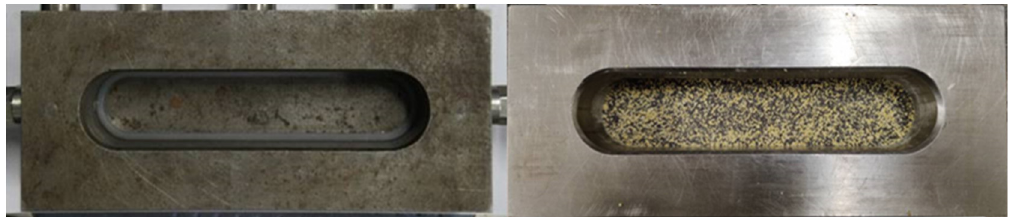
Figure 2. Diversion chamber before and after the placement of the plugging agent and